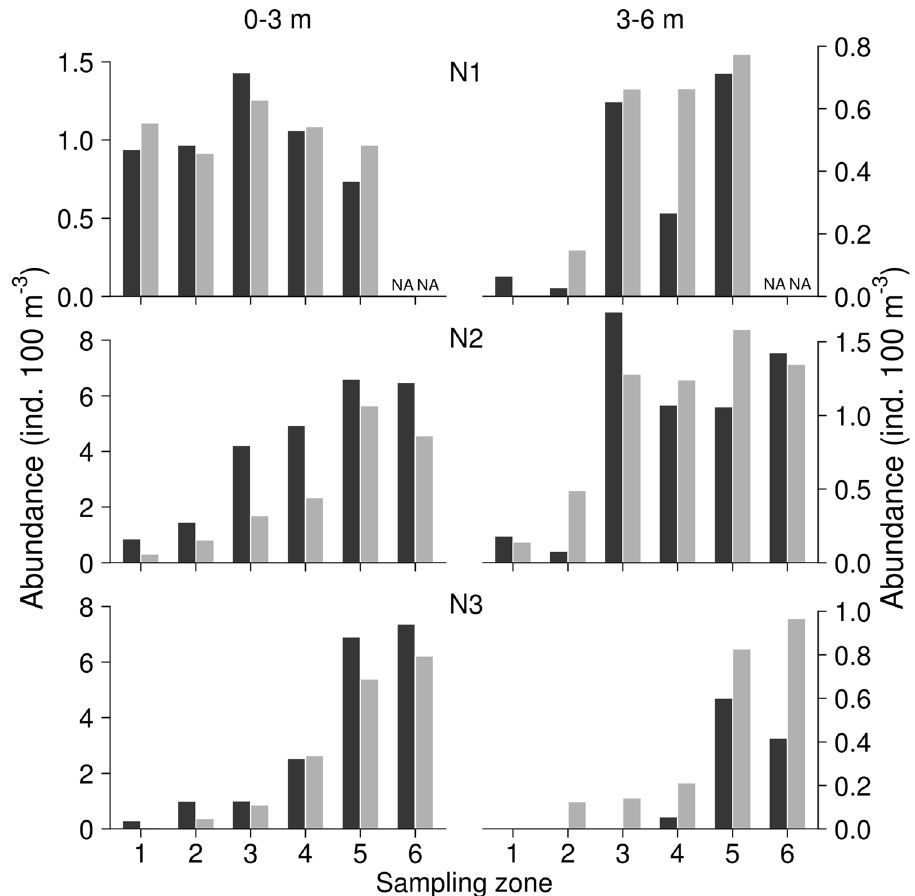
Figure 5. Replicability of abundance results of the two subsequent acoustic surveys (38 kHz). Abundance estimates obtained from the upward-looking hydroacoustic system during the three night of sampling (N1, N2 and N3) in each of the six sampling zones and in both the 0–3 m (left column) and 3–6 m (right column) depth layers. The estimates obtained during the upstream cruise are shown in black and those obtained during the downstream cruise are shown in grey. NB: in 3–6 m layer occasionally no fish of relevant size occurred. NA – not sampled.